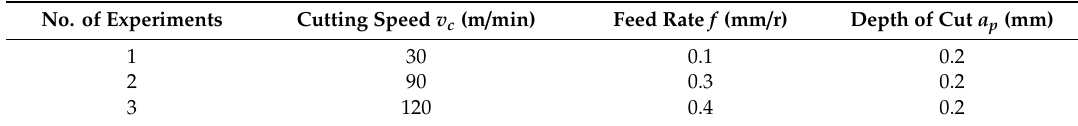
Table 3. The turning experiment